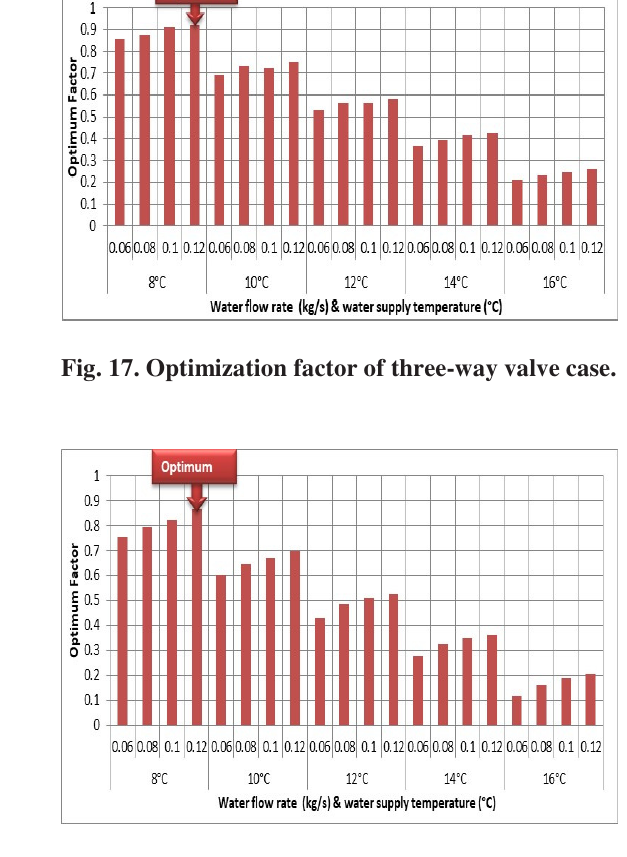
Fig. 18. Optimization factor of two-way valve